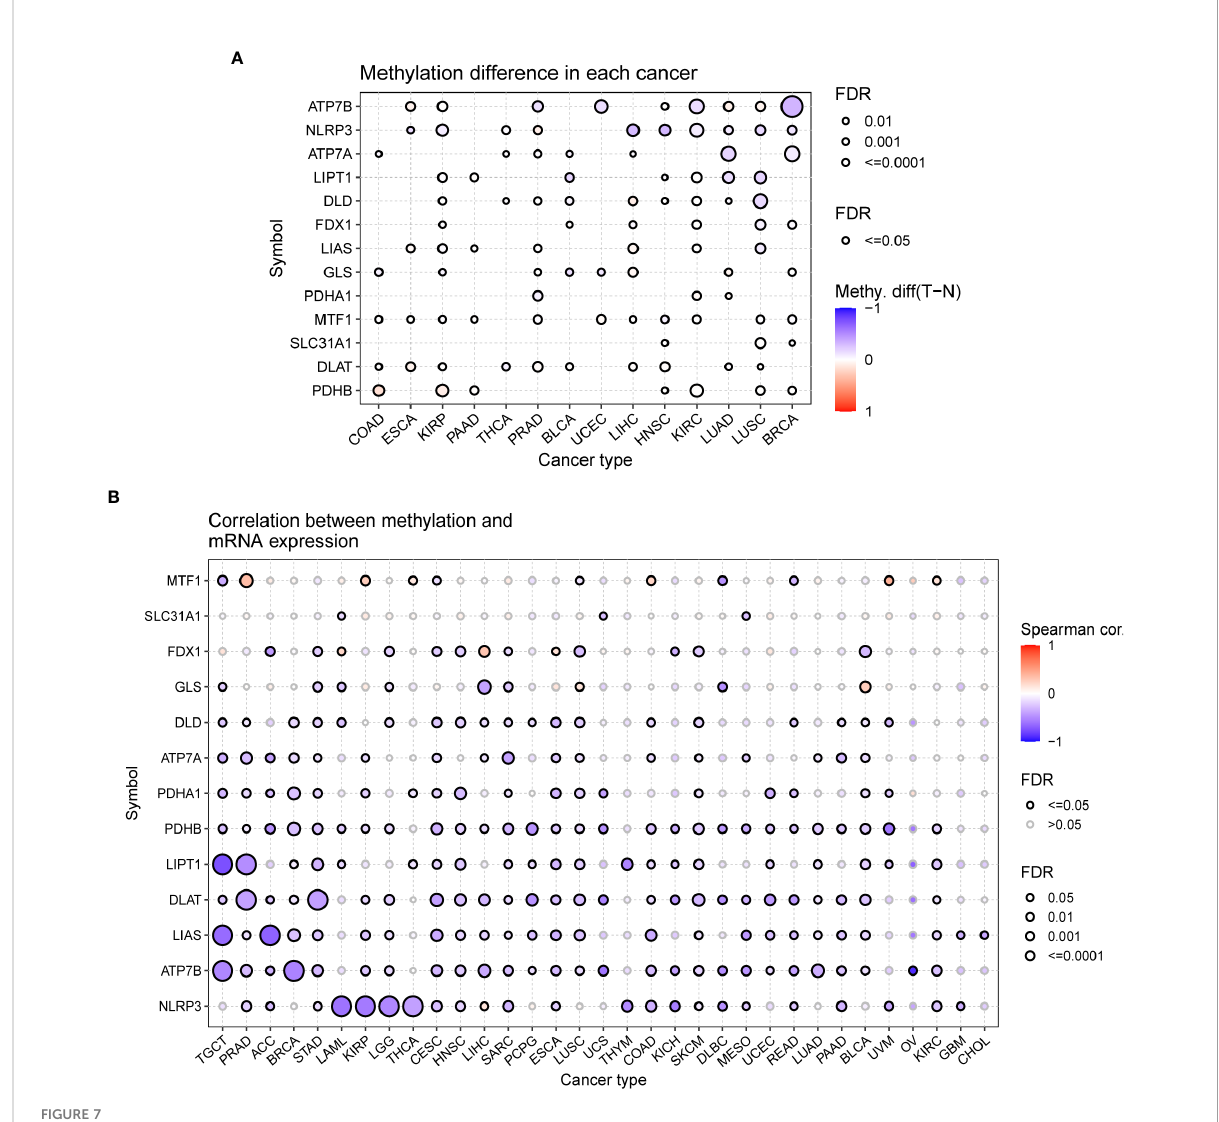
FIGURE 7 Methylation analysis of cuproptosis-related genes (GSCALite). (A) Methylation bubble plot showing differences in the methylation of cuproptosis-related genes between tumor and healthy tissue samples. The blue dots represent downregulation of methylation in tumor tissues compared with healthy tissues, and the red dots represent upregulation of methylation in tumor tissue compared with healthy tissues; the darker the color, the greater the difference. The size of the dots represents statistical signi fi cance, with larger dots being more signi fi cant. (B) The correlation between methylation and mRNA expression was analyzed via Spearman correlation analysis. The blue dots represent negative correlations, and the red dots indicate positive correlations; the darker the color, the higher the correlation. The size of the dots represents statistical signi fi cance, with larger dots being more signi fi